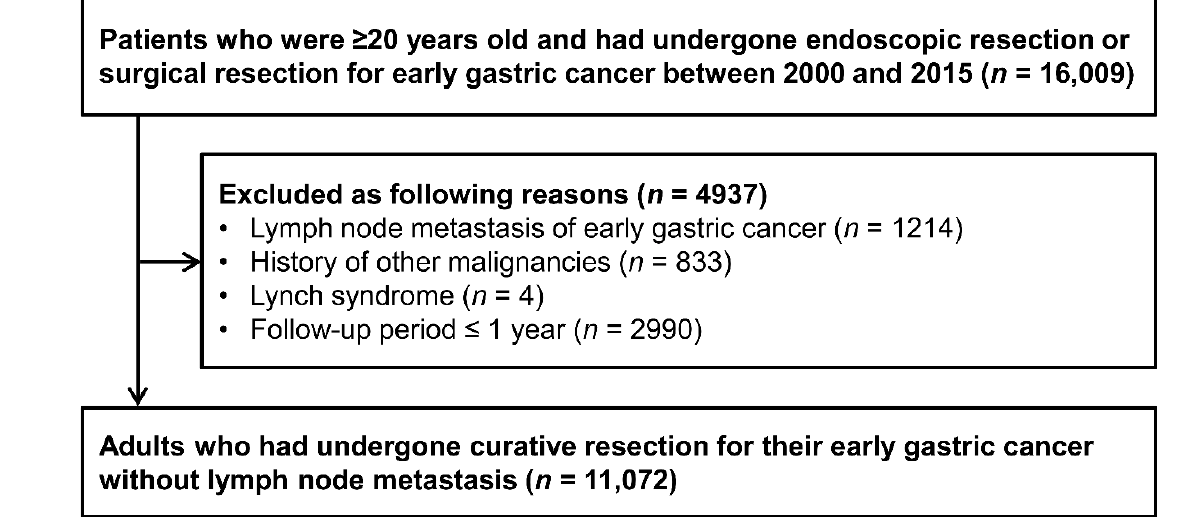
Figure 1. Flowchart of patient selection criteria.